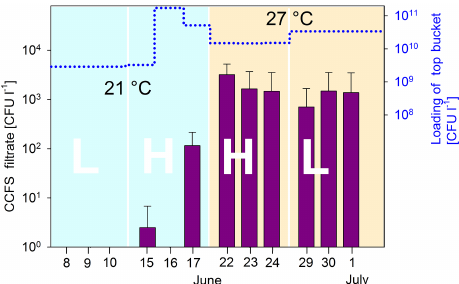
Figure 3. Stepwise laboratory performance tests. Blue dotted line: loading rates of the top buckets; bars denote the mean, errors bars the standard deviation of coliform counts in the filtrate of four repli- cates as detected by the membrane filter method; L stands for low, H for high filling scenario.